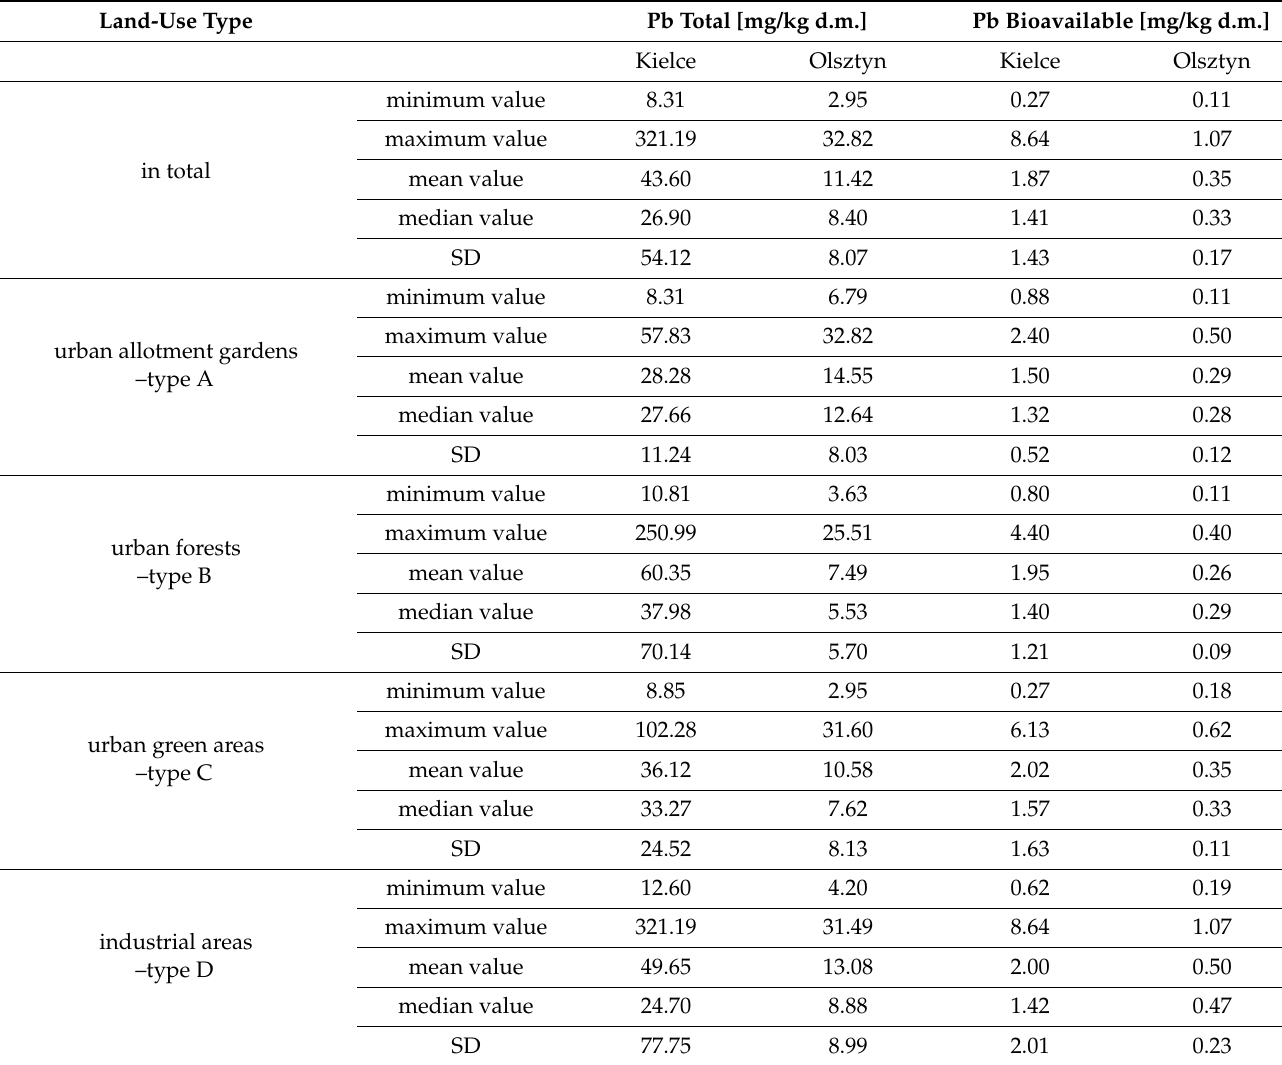
Table 4. Statistics concerning the content of lead in the studied soils in Kielce and Olsztyn with regard to land-use types. Land-Use Type Pb Total [mg/kg d.m.] Pb Bioavailable [mg/kg